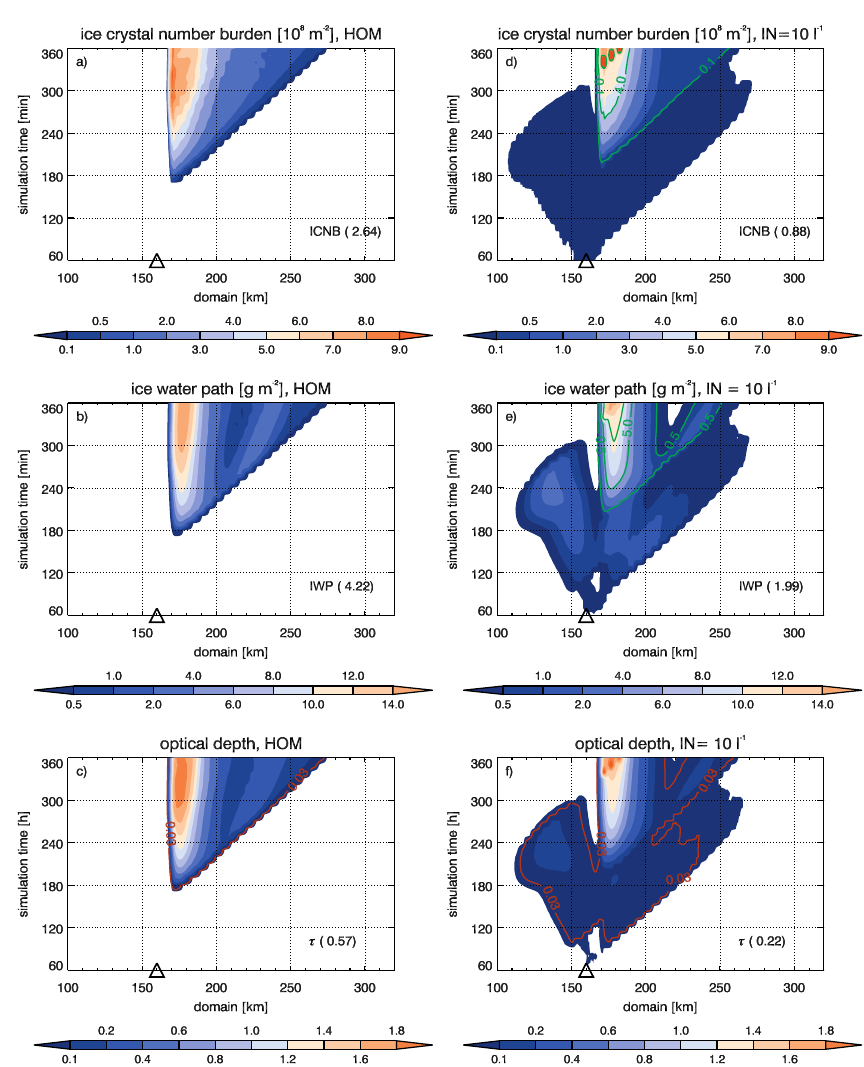
Figure 4. Time evolution of (a, d) ice crystal number burden, (b, e) ice water path and (c, f) optical depth for simulation HOM (left column) and 10 IN (right column) for the reference temperature profile and RHi het = 130%. The red line shows where τ = 0 . 03, and the triangle denotes the position of the top of the mountain. The green lines show the ICNB and IWP for the homogeneously frozen ice crystals with values of 0.1, 4, 9 × 10 8 m − 2 for ICNB and 0.5, 5, 8gm − 2 for the IWP. The numbers in brackets show the mean values; the mean is only calculated where τ > 0 . 03. Note that the time of the day is not specified for these simulations without